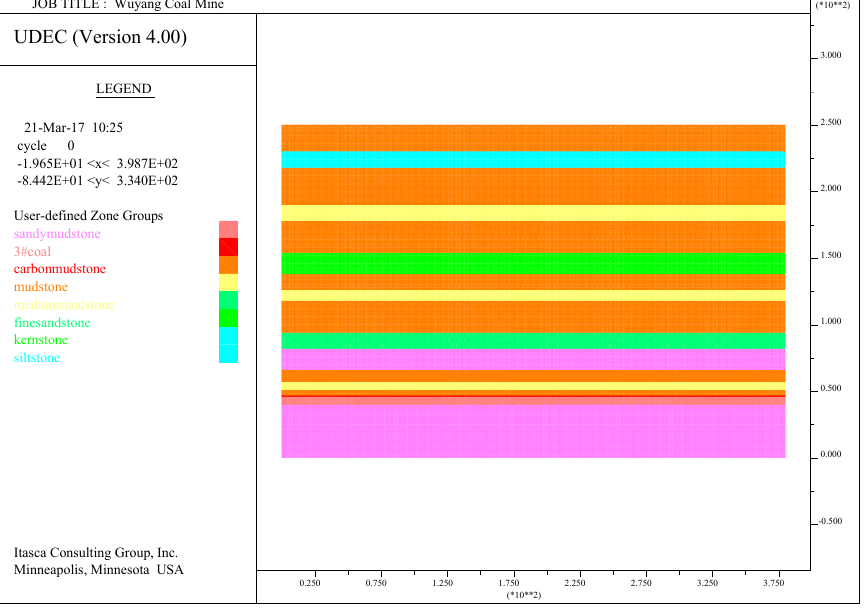
Figure 3. Numerical calculation model.